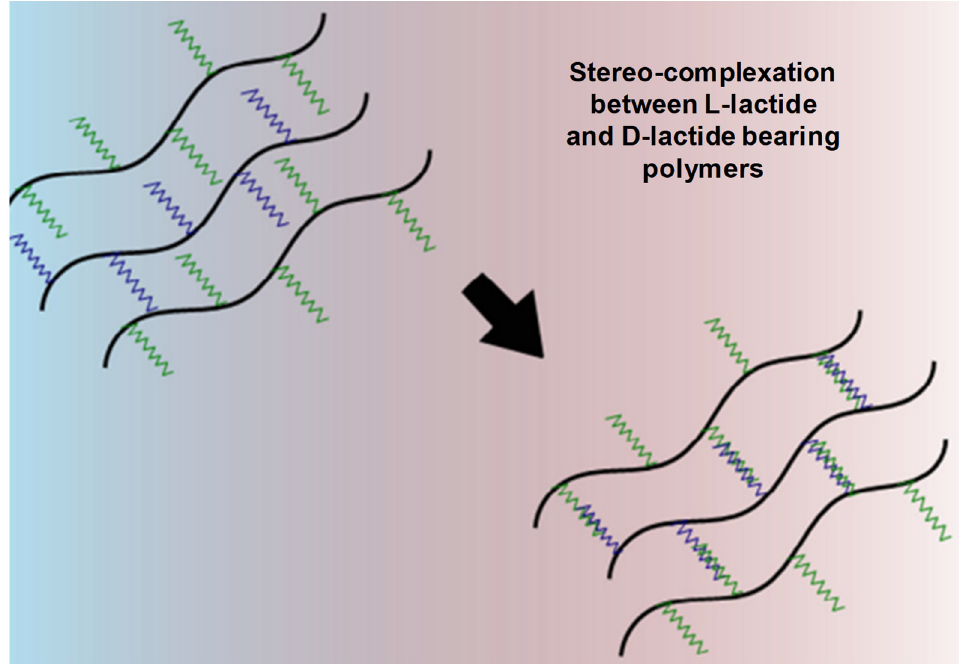
Figure 10. Mechanism of gelation by stereo-complexation between D-lactide- and L-lactide-bearing polymers. Adapted with permission from ref. [8]. Copyright © 2015 European Polymer Journal .